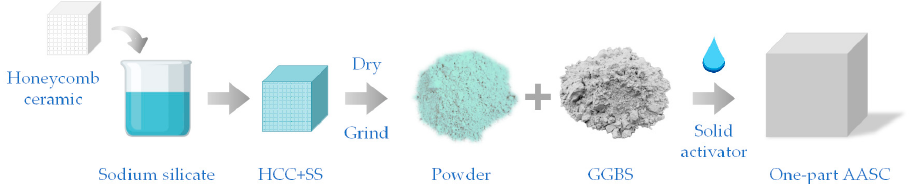
Table 2. Common treatment processes and their